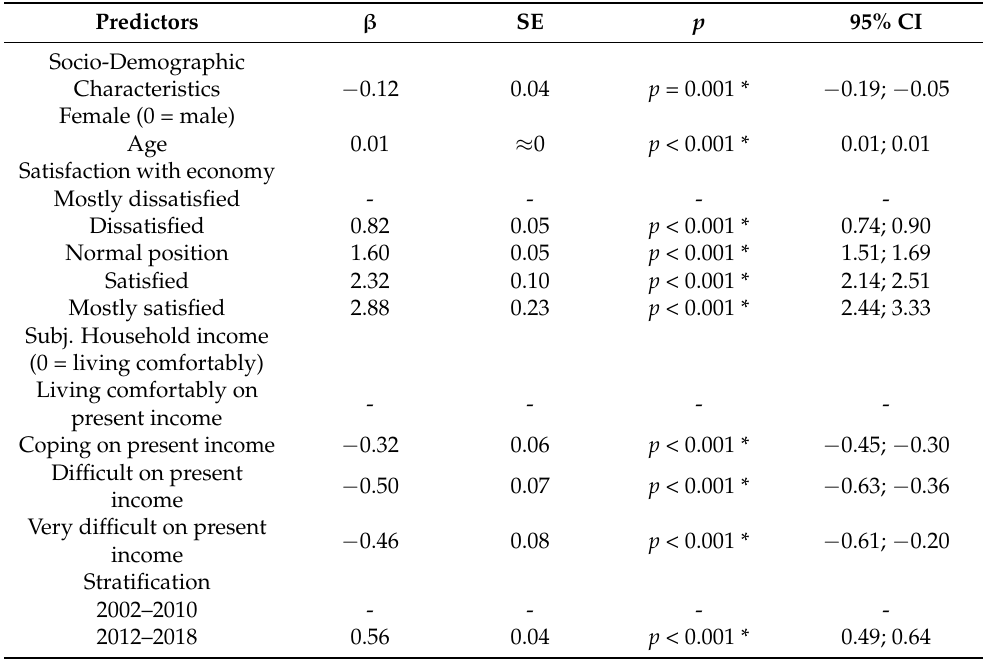
Table 4. Model 2—current economic situation adjusted for stratification